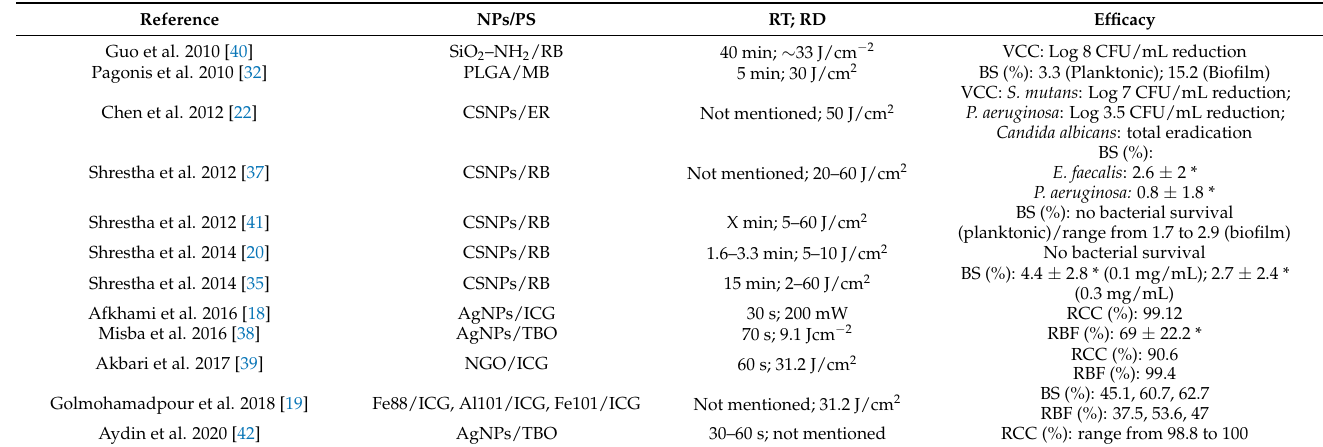
Table 2. Treatment efficacy